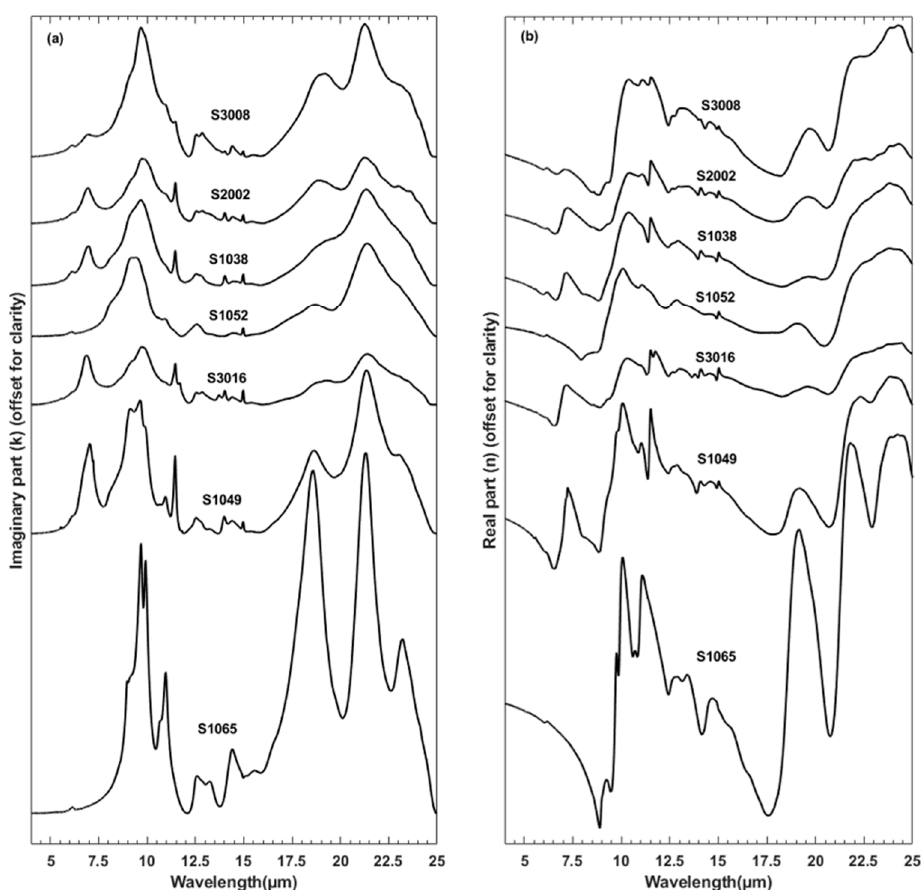
Figure 4. ( a ) k and ( b ) n values derived in this study. Spectra in both plots are offset for clarity. Samples were selected to show diversity. The Zenodo archive (https://doi.org/10.5281/ze ‐ nodo.7672177) includes values for all 26